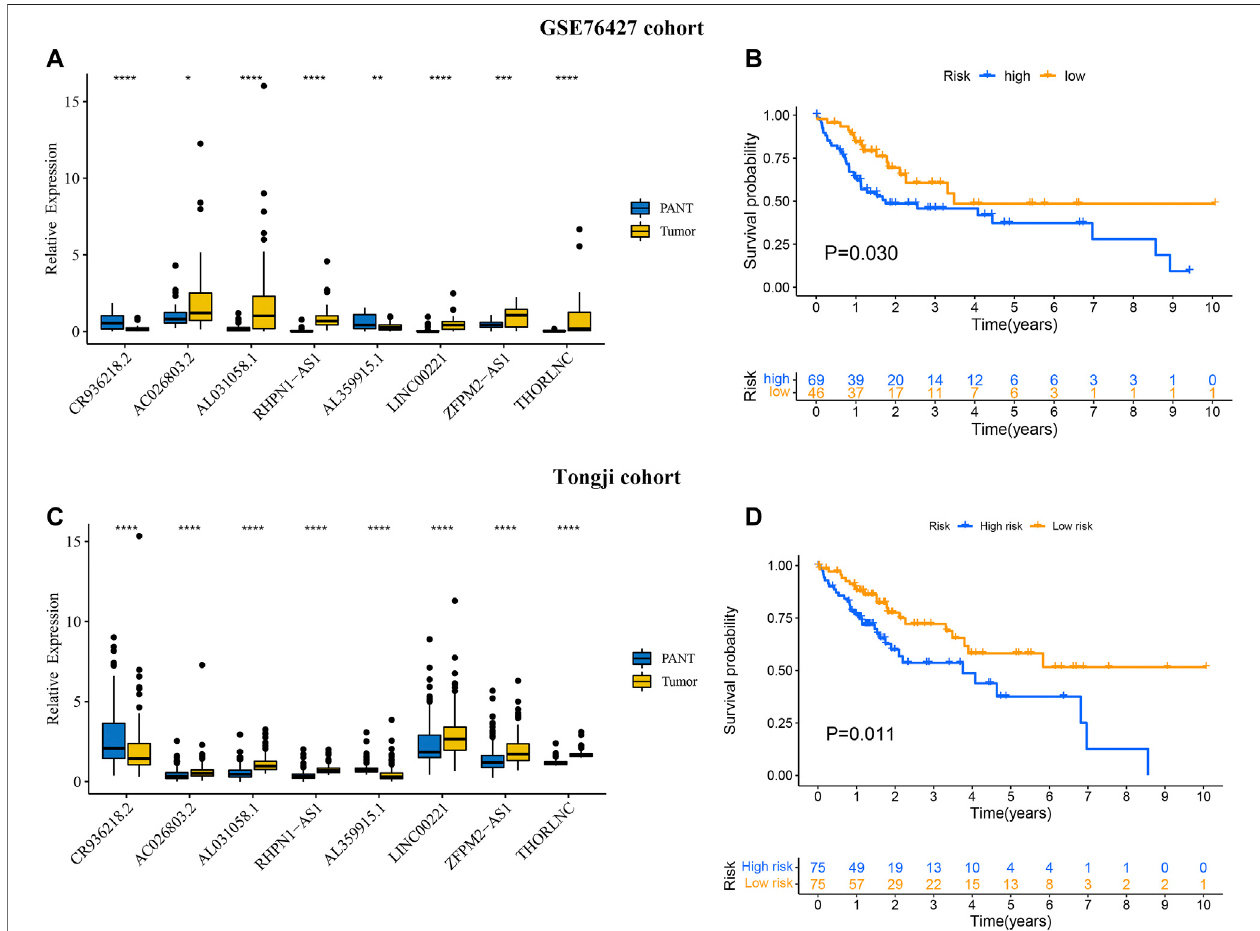
FIGURE 8 | Validation of the prognostic performance of GIlncSig on GSE76427 and Tongji datasets. The expression level of eight GILncs for the HCC and paired adjacentnormaltissue(PANT)inGSE76427 (A) andTongjidatasets (C) .Kaplan – Meiercurvesillustratedthatpatientswithhighriskhadworseoverallsurvivalthanthose with low risk in GSE76427 (B) and Tongji datasets (D)